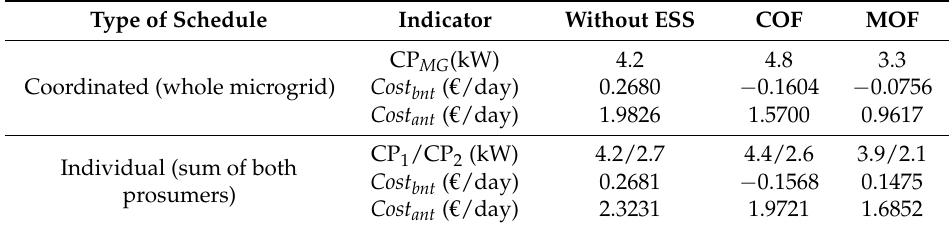
Table 6. Economic indicators for the whole microgrid, and individual CP and sum of both prosumers costs with individual schedule.